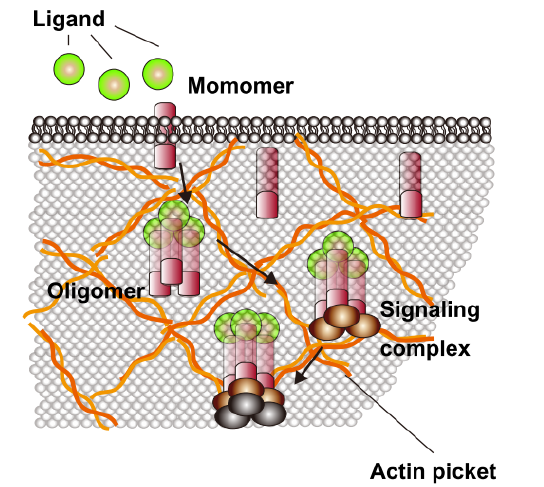
Figure 2. A schematic presentation of the membrane-skeleton fence model. Membrane proteins are sticking out into the cytoplasm, and in their cytoplasmic domains, collide with the membrane actin skeleton, which causes confinement of these membrane proteins into membrane skeletal meshes. When extracellular ligand molecules are added, they are bound to a receptor monomer and form oligomers. This action induces a dramatic decrease in the diffusion rates of such signaling complexes because of the enhanced effects of corralling or binding to the fences, and these signaling complexes are immediately arrested within the compartment where the signal was